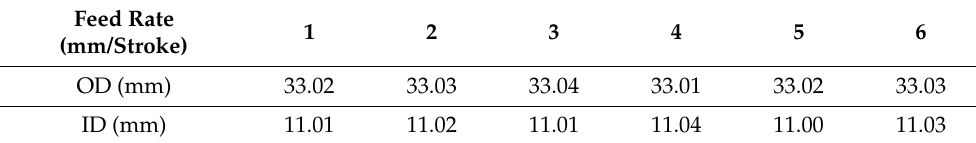
Table 3. The evolution of diameter with the increase in feed rate. Feed Rate